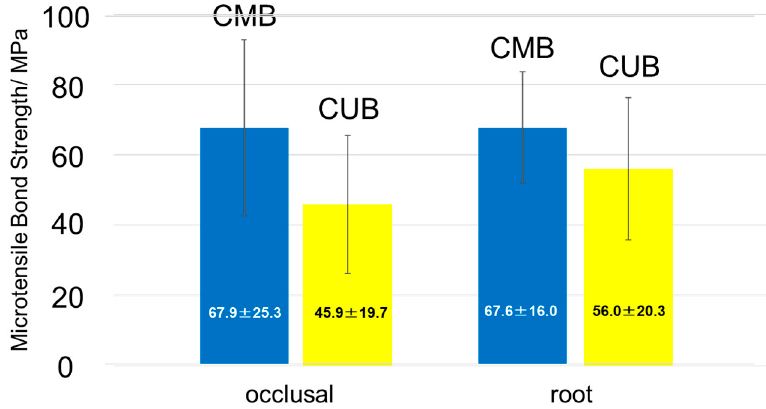
Figure 3. Microtensile bond strength ( μ TBS). CMB (blue), CUB (yellow); ( p > 0.05).